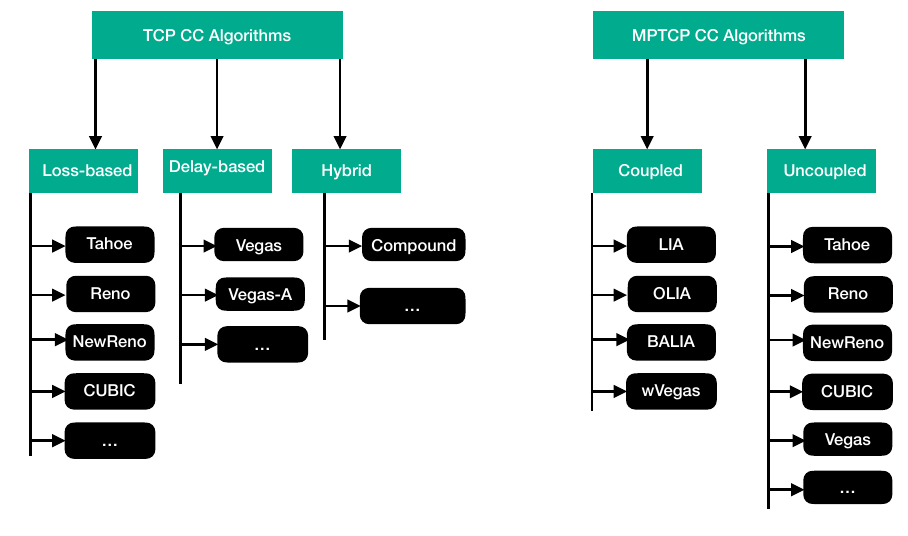
Figure 5. TCP Furthermore, MPTCP CC